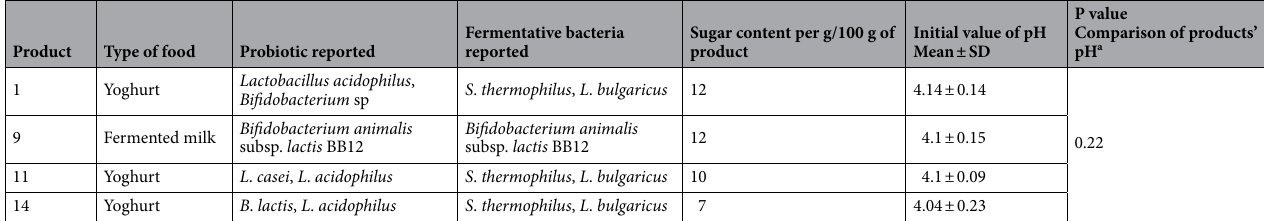
Table 2. Characteristics of the selected foods. ANOVA test performed according to data normality and homogeneity. *P < 0.05, **P <